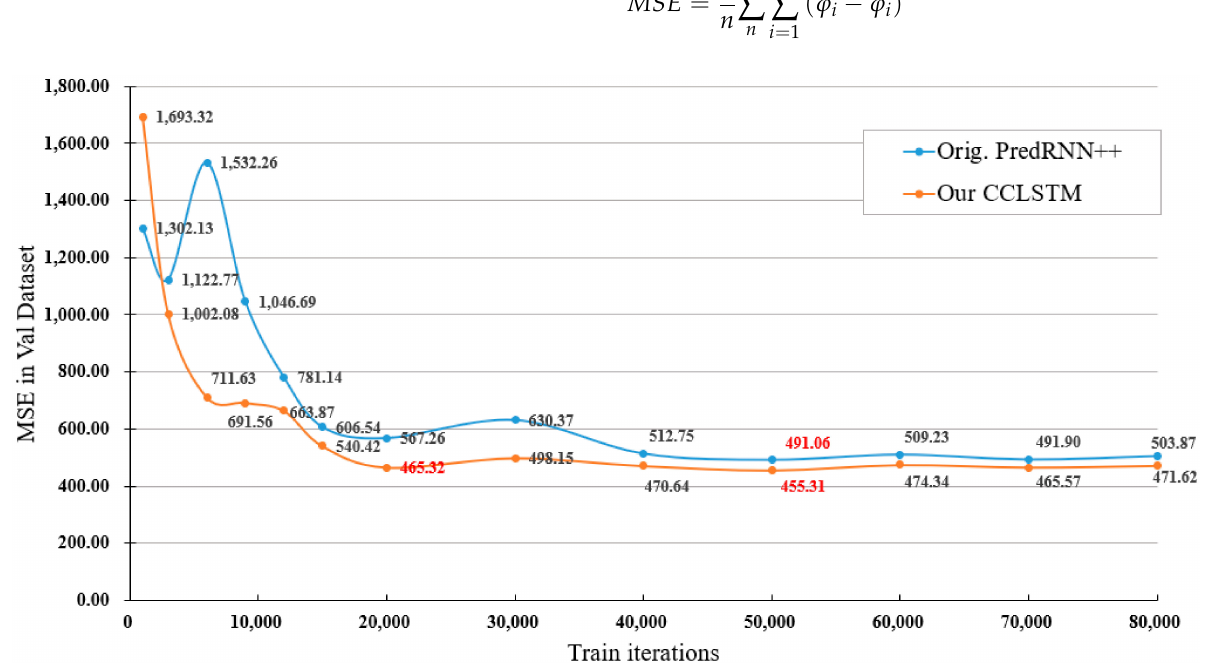
Figure 8. The MSE drop of the validation set during the training process of the PredRNN++ and our